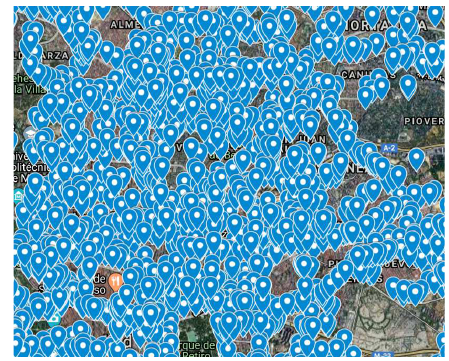
Figure 1. Traffic intensity sensors in Madrid.